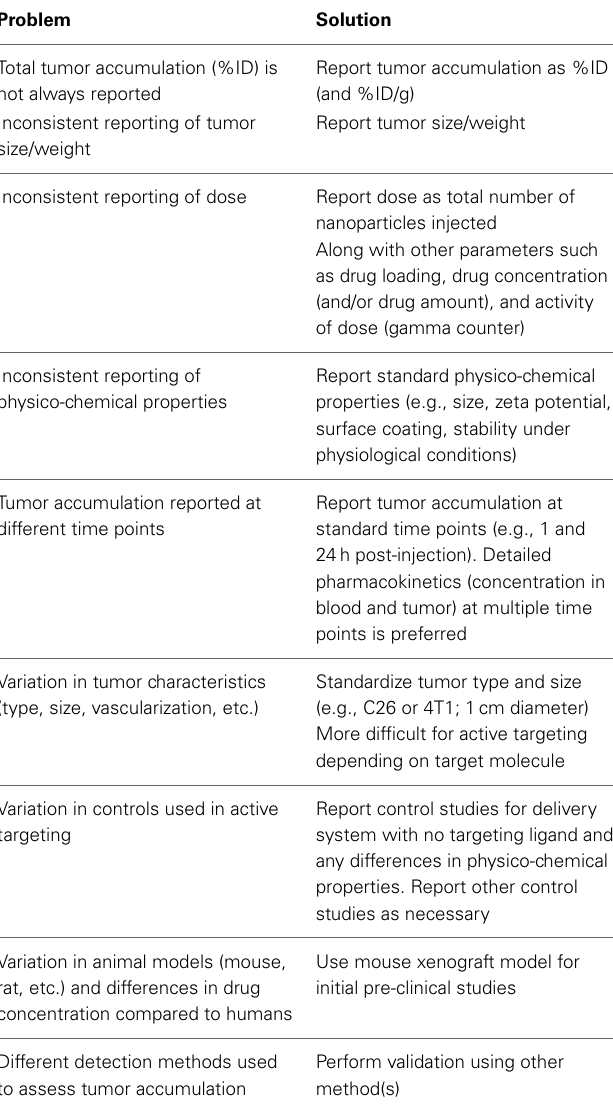
Table 4 | Summary of limitations to pre-clinical studies of nanomedicines that hinder broad assessment of design